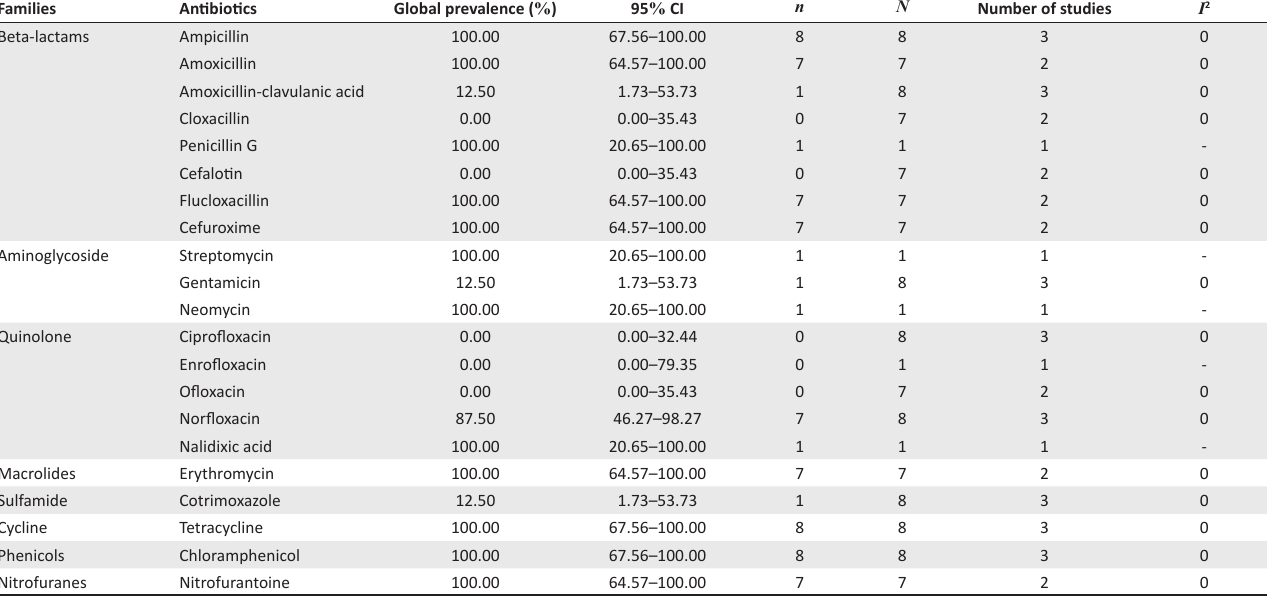
TABLE 6: The overall prevalence of antibiotic resistant Streptococcus pyogenes strains isolated from dogs in Africa.